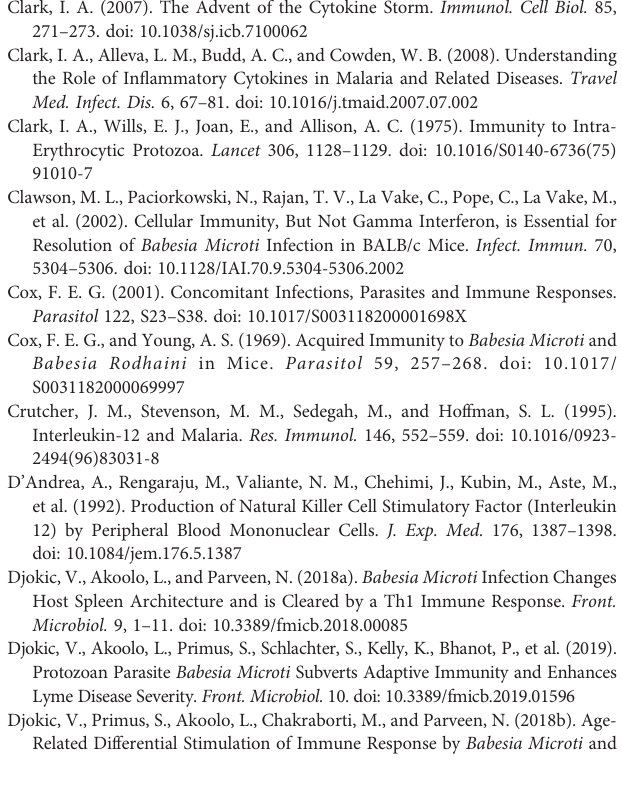
Supplementary Figure 1 | Gating scheme for fl uorescence-activated sorting (FACS)analysisofimmunecells.Atotalof50,000eventswereanalyzed.Eachpanel is a representative image of gating for (A) singlets, (B) CD45 + (immune cells), (C) CD45 + F4/80 + (macrophages), (D) CD45 + CD11c + (dendritic cells), (E) CD45 + CD19 + (B lymphocytes), (F) CD45 + CD3 + (T cells), and (G) CD45 + CD49b + (natural killer cells). Supplementary Figure 2 | Babesia microti parasitemia levels in co-infected (bm/ br2, bm/br4, and bm/br6) groups prior to challenge infection with B. rodhaini and parasitemia of Bm group. Supplementary Figure 3 | Immuno fl uorescence microscopy images of blood smears from (A) co-infected mouse challenged at day 4 post-primary B. microti infection and (B) mouse with B. rodhaini infection only. Alexa Fluor ® 594- conjugated goat anti-rabbit IgG (green) and Alexa Fluor ® 488-conjugated anti- mouse IgG (red) were used as parasite markers. Supplementary Figure 4 | Kinetics of serum antibodies speci fi c to B. microti after B. rodhaini challenge infection. The production of (A) IgM, (B) IgG, (C) IgG1, (D) IgG2a, (E) IgG2b, (F) IgG2c, and (G) IgG3 in mice after challenge infection with B. rodhaini was determined. Babesia microti only infection (Bm) and B. rodhaini and B. microti co-infected groups (bm/br4 and bm/br6). Detection of IgGs and IgM was performed at days 2, 4 and 6 in all groups. For detection of serum antibodies against B. microti , rBmP32 protein was used as detection antigen in ELISA assays. The results are expressed as mean values ± the SD of six mice. Asterisks indicate statistical signi fi cance ( * p < 0.05; ** p < 0.01; *** p < 0.001). Supplementary Table 1 | Antibody panel used for sorting antibody-tagged splenocytes. Supplementary Table 2 | Estimated total count and percentage of immune cell populations. * Estimated numbers obtained from the mean percentage of immune cell